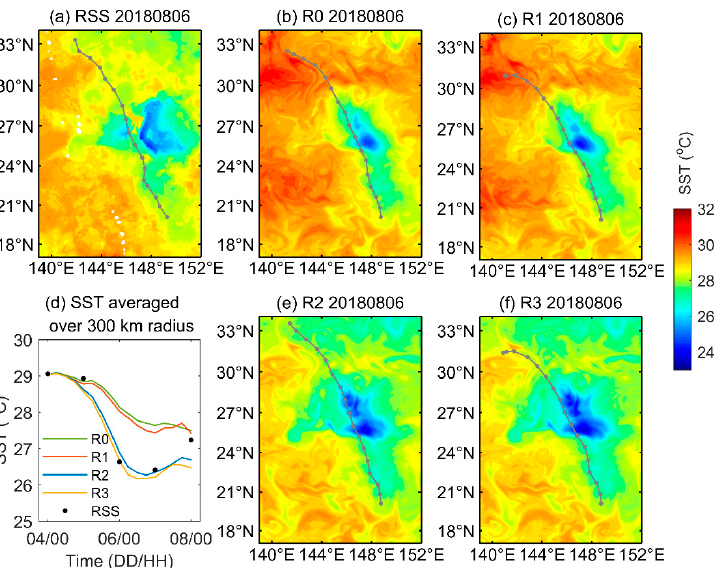
Figure 10. Daily mean SST on 6 August 2018 for Shanshan. ( a ) SST from RSS observations; ( b , c , e , f ) simulated SSTs from R0, R1, R2, and R3, respectively; ( d ) time series of SSTs averaged over 300 km radius inner core region along Shanshan center location.